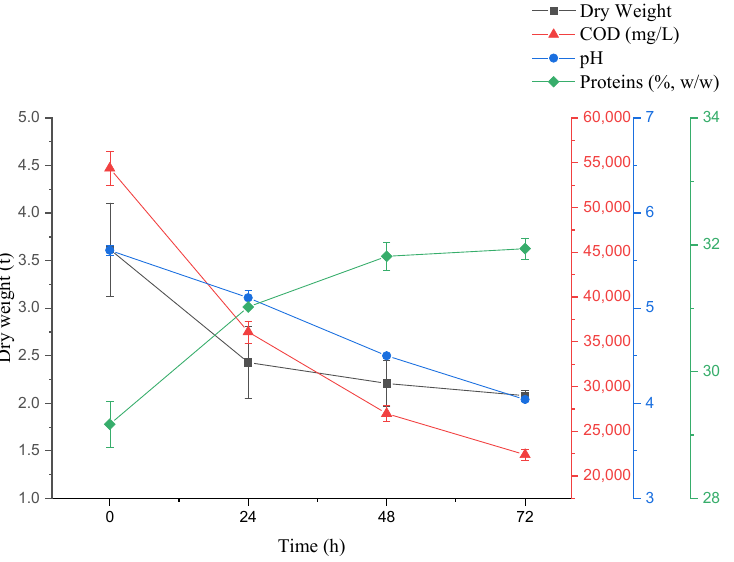
Figure 2. Component changes of wastewater composition. Error bars show a standard error from triplicate observations.